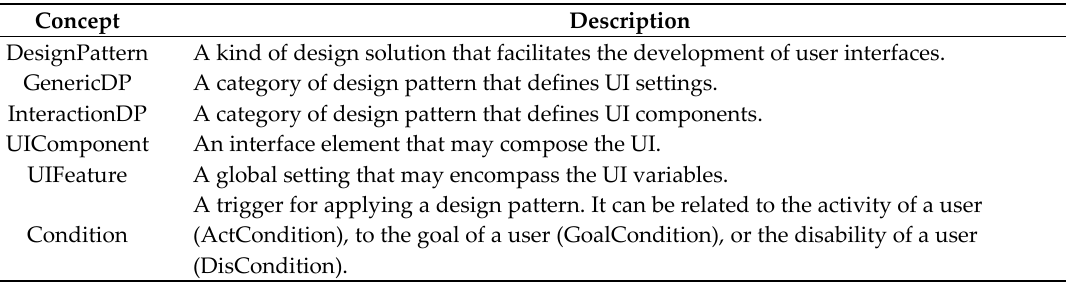
Table 2. Description of UI design pattern ontological concepts.